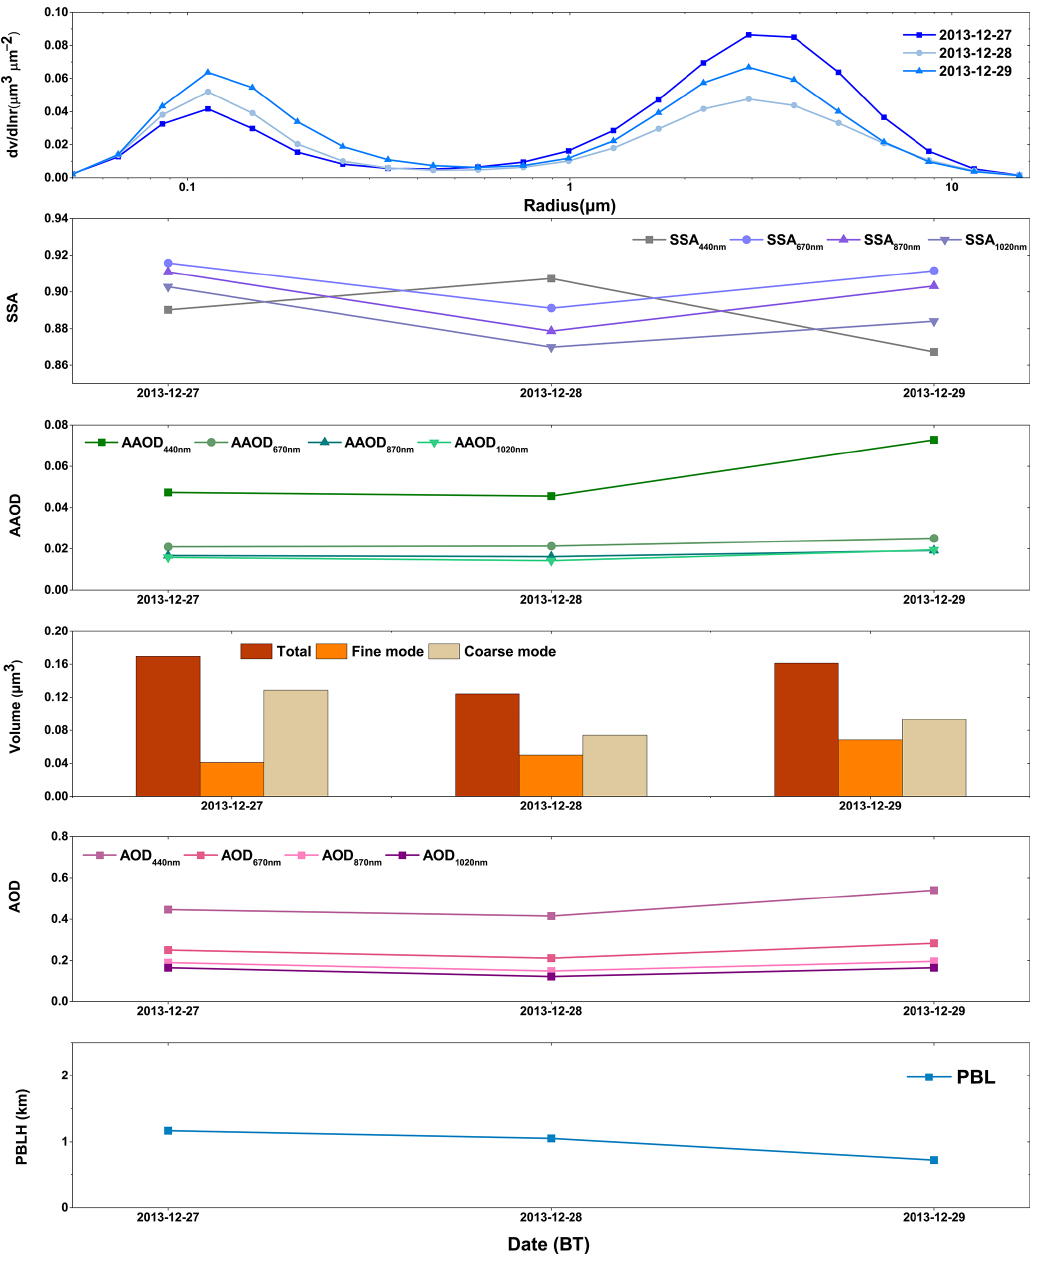
The accumulation of locally emitted pollutants is